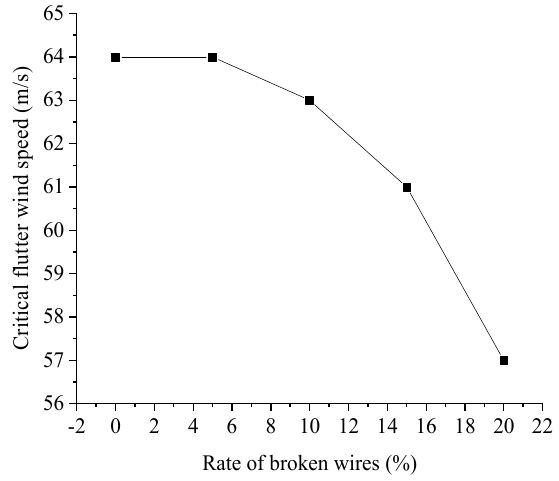
Figure 14. Change curve of flutter critical wind speed with wire breaking rate.